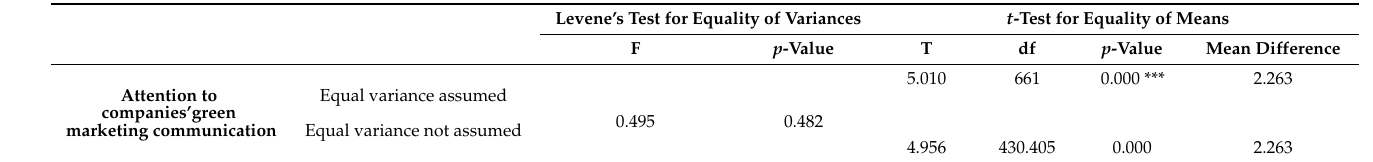
Table 3. Results of the t -test for the mean difference in consumers’ attention to companies’ green marketing communication, exploring gender